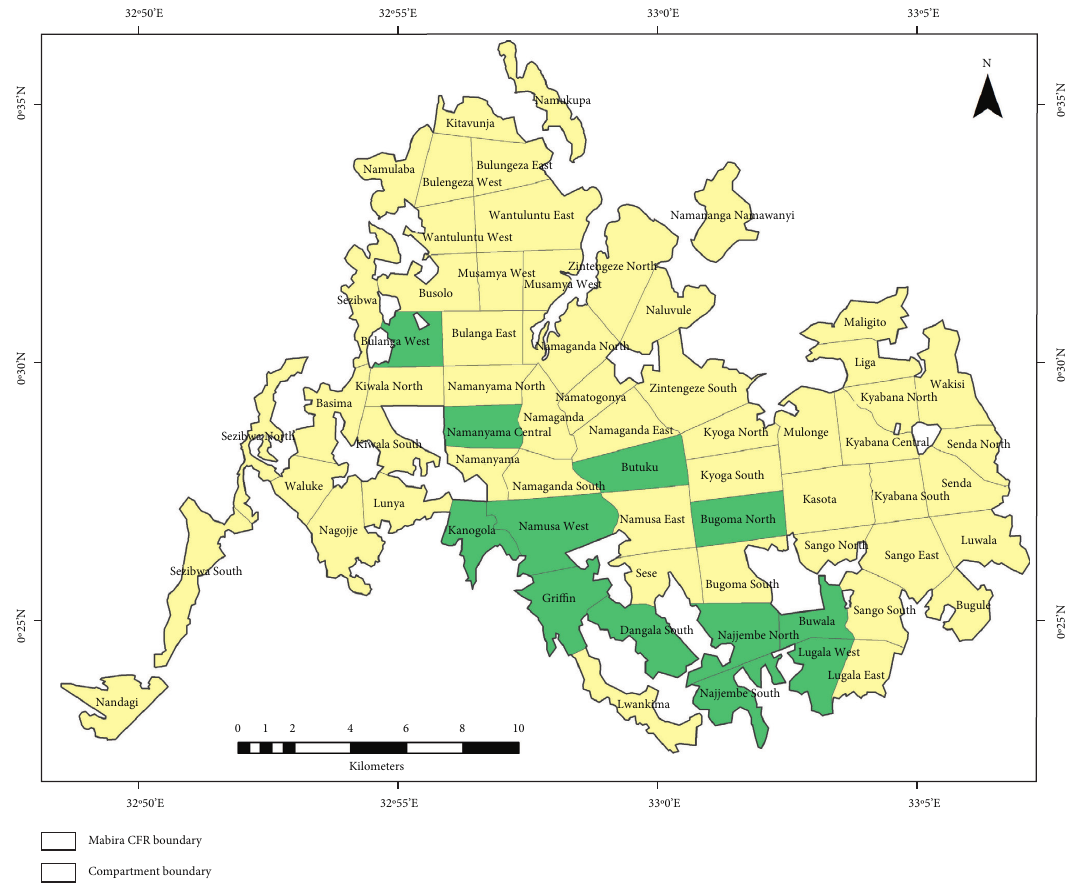
Figure 1: Map of Mabira Central Forest Reserve showing areas (shaded green) of search of C. articulata